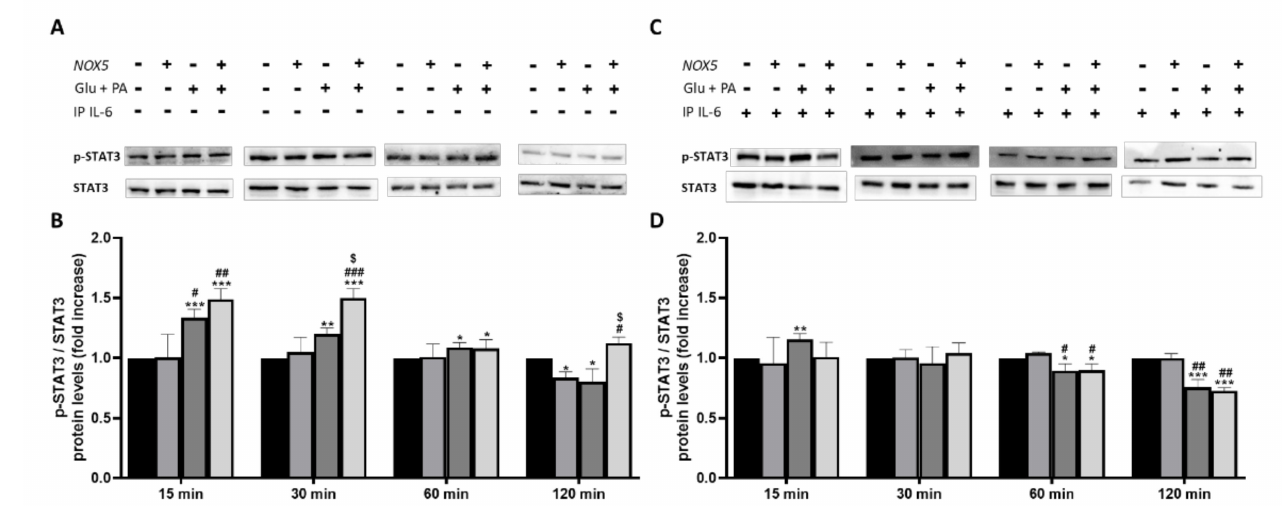
Figure 7. Phosphorylation levels of STAT3 are increased in 3T3-L1 adipocytes when cultured for 30 min with Glu + PA conditioned media from NOX5-expressing endothelial bEnd.3 cells ( A , B ). This increase is prevented when IL-6 is immunoprecipitated from the media ( C , D ). ( A , C ) Representative images of Western blots for p-STAT3 and STAT3. ( B , D ) p-STAT3 and STAT3 protein levels of 3T3-L1 adipocytes ( n = 6). Results are expressed as mean ± SEM; * p < 0.05, ** p < 0.01, *** p < 0.001: differences relative to Nox5( − )/Glu + PA( − ); # p < 0.05, ## p < 0.01, ### p < 0.001: differences relative to Nox5(+)/Glu + PA( − ); $ p < 0.05: differences relative to Nox5( − )/Glu + PA(+);. Statistical test used: